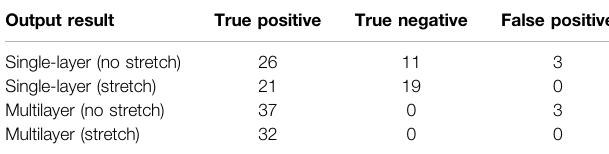
TABLE 3 | Comparison of single-layer and multilayer true and false output